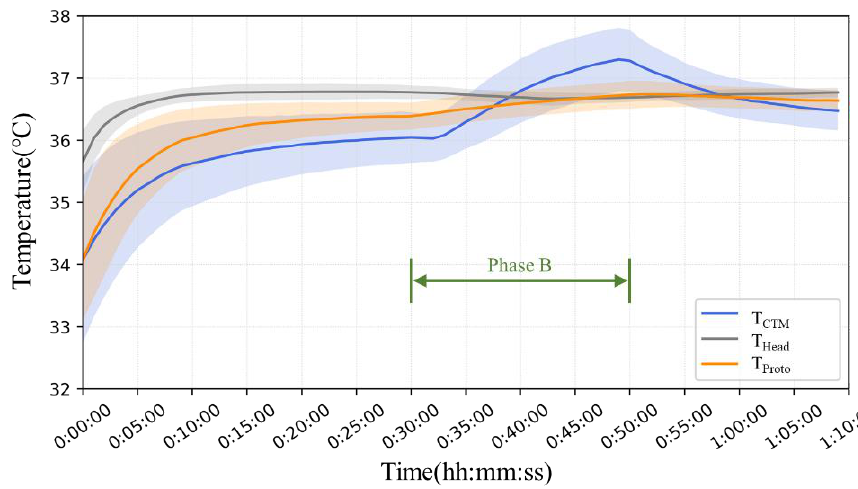
Figure 10. The means and error bands of the measurement results of all seven subjects.